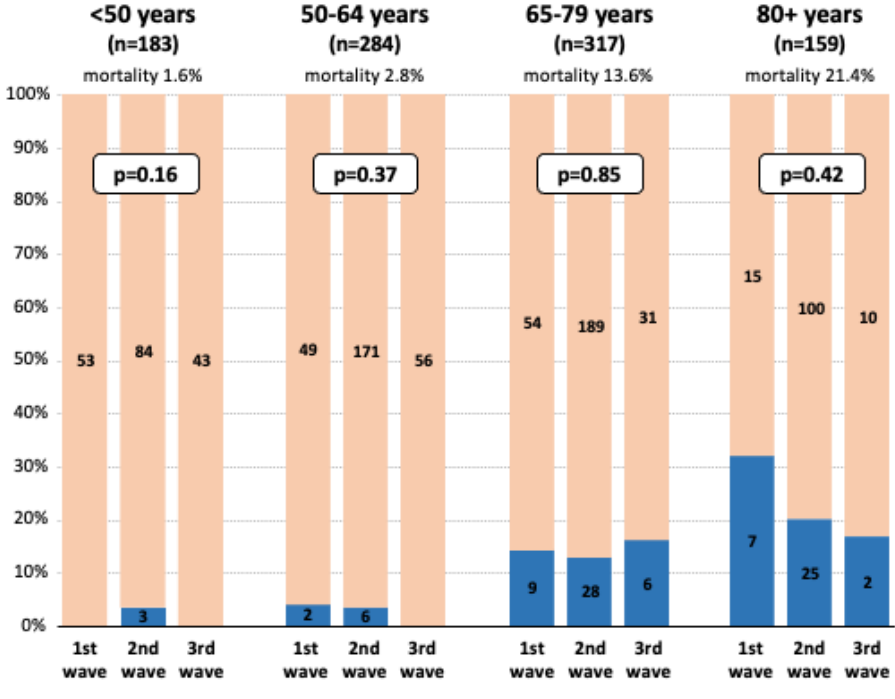
Supplemental figure S3 . Mortality of each wave stratified by the age